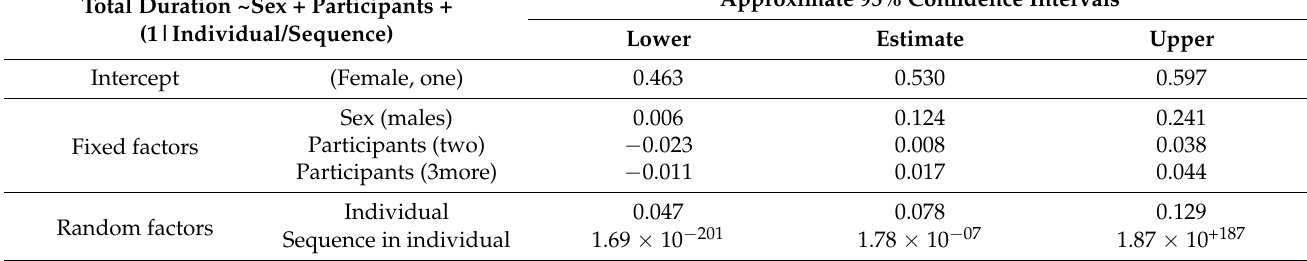
Table 2. Intervals of the linear mixed model of Total Duration of captive maned wolves roar-barks ( N = 200). Values are shown in seconds. ‘Participants’ is the number of vocally interacting animals in the sequence from which the roar-bark was selected. There are 10 individuals, 6 females and 4 males. Total number of different sequences combined with individuals is 89.